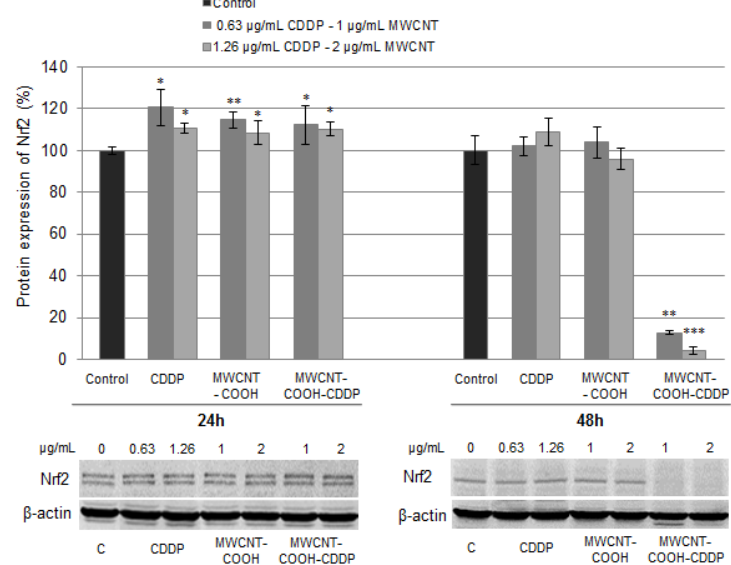
Figure 12. Relative protein expression of Nrf2 after the exposure of MDA-MB-231 cells to MWCNTs (0.5–4 µg/mL) and CDDP (0.316–2.52 µg/mL) for 24 h and 48 h. The graph is the correspondent (0.5–4 µ g/mL) and CDDP (0.316–2.52 µ g/mL) for 24 h and 48 h. The graph is the